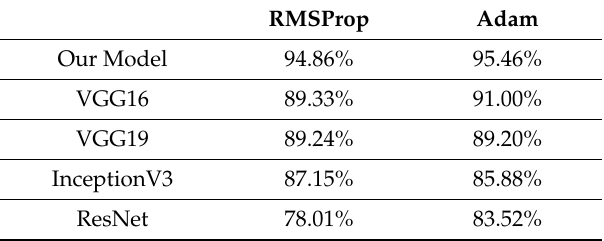
Table 7. The AUC results obtained with benchmark architectures under the fourth